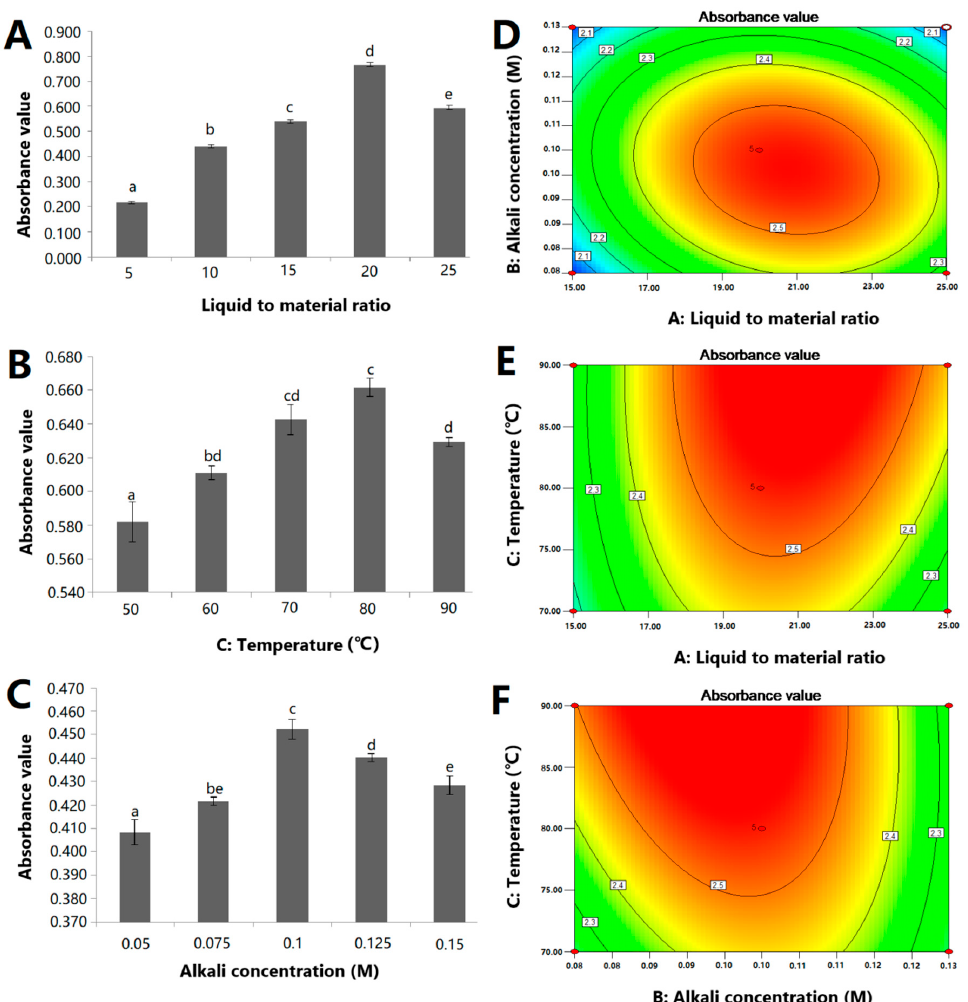
Figure 1. Effects of singlefactor and two-factor interactions on the polysaccharide extraction yield of Ziziphus jujuba cv. Muzao residue polysaccharides (ZJRP). ( A ) Liquid-to-material ratio, ( B ) extraction temperature, ( C ) alkali concentration, ( D ) alkali concentration and liquid-to-material ratio, ( E ) extraction temperature and liquid-to-material ratio, and ( F ) extraction temperature and alkali